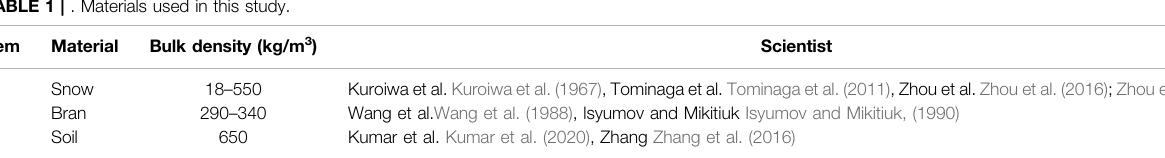
TABLE 1 | . Materials used in this